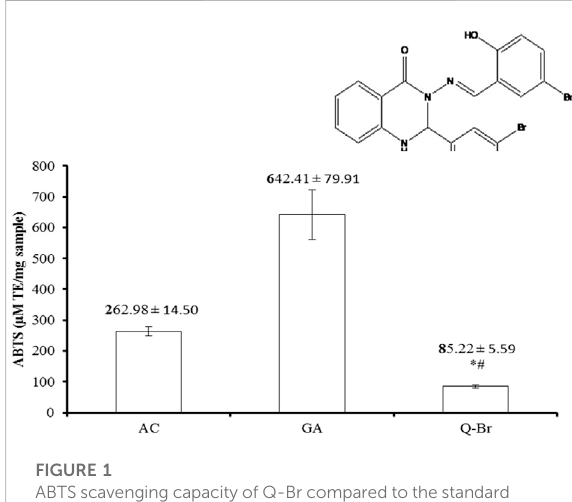
FIGURE 1 ABTS scavenging capacity of Q-Br compared to the standard ascorbic acid (AC) and gallic acid (GA). The data are displayed as mean ± SD ( n = 3) and p ≤ 0.05 was considered signi fi cant. * p < 0.01 vs. AC and # p < 0.001 vs. GA. The structure of the synthetic quinazoline Schiff base compound, 3-(5-Bromo-2- hydroxybenzylideneamino)-2-(5-bromo-2 hydroxyphenyl)-2,3- dihydroquinazoline-4(1H)-one(Q-Br)is indicated above Q-Br